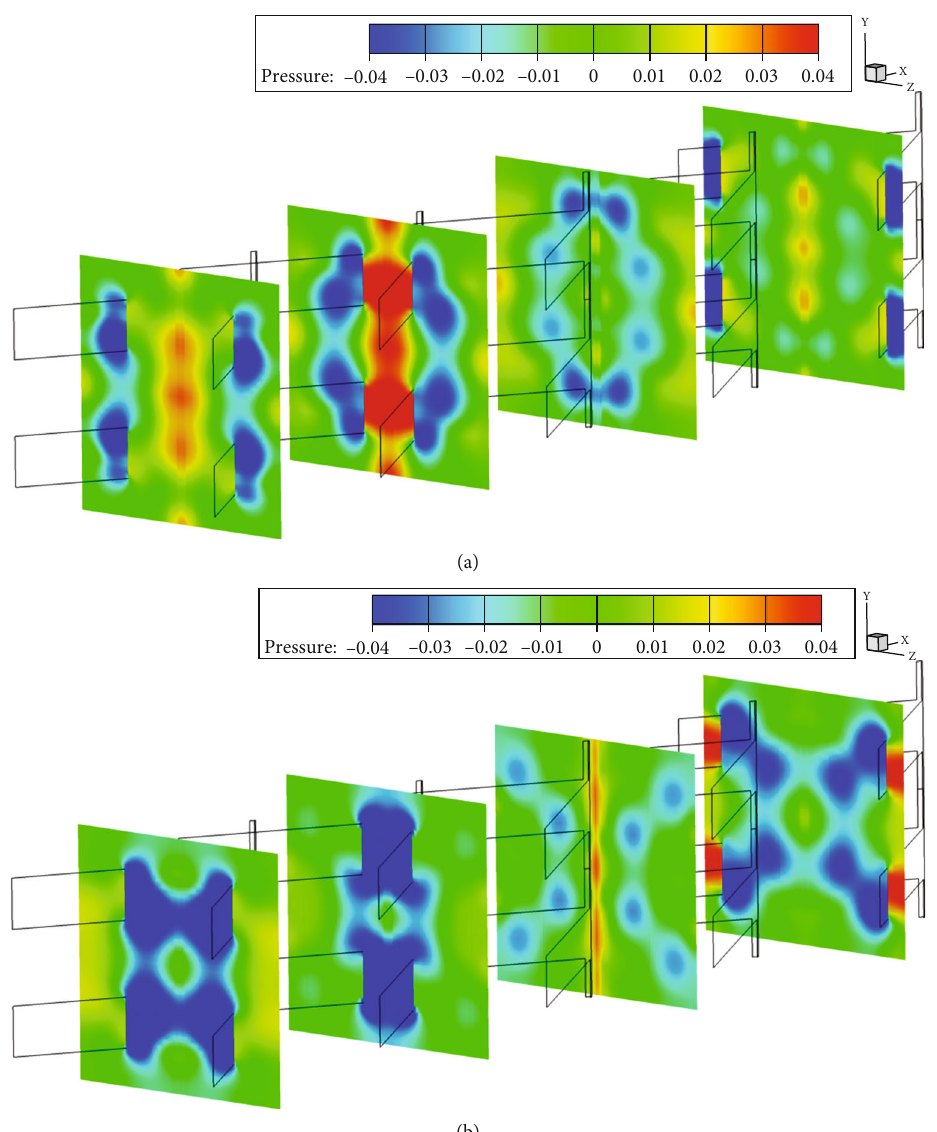
Figure 4: Pressure contours in transverse planes for the ba ffl ed duct with b / H = 0 : 20 and s / H = 0 : 15 at Re = 800 of (a) VD and (b)